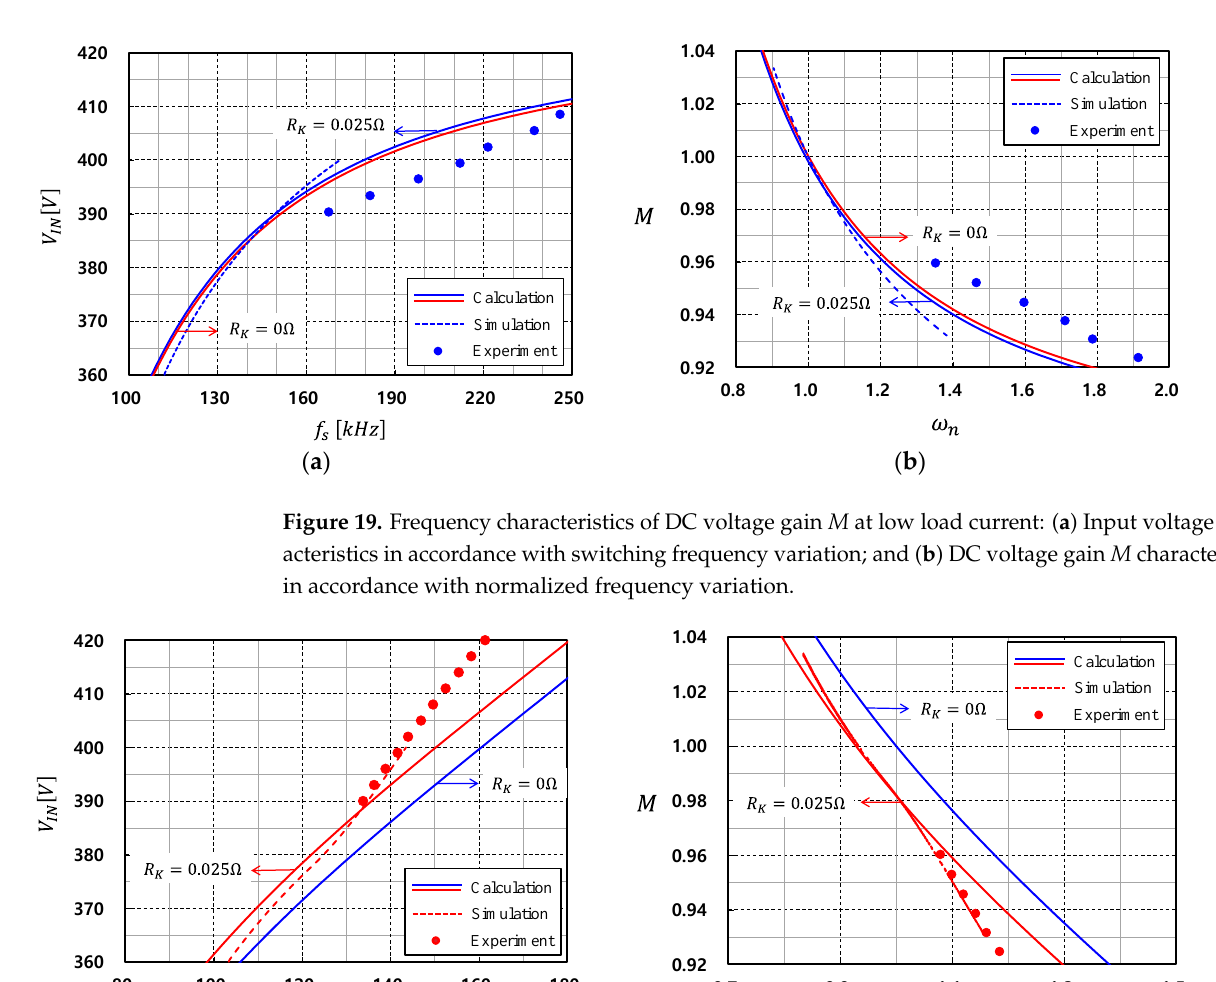
Figure 22. Measured power conversion efficiency of the experimental circuit. 5. Discussion In order to confirm the validity of the steady-state characteristic equation and the optimal design process, a converter with a maximum output of 2 kW, an input voltage of 390 V, an output voltage of 54 V, and a resonance frequency of 125 kHz was designed, and we compared the simulation, calculation, and experimental results. First, at low out- put current, there was a difference between the experimental value and the calculated value due to the fundamental harmonic approximation (FHA) method, which increases the error at no load, being used for the voltage gain equation. As the load power increased, the calculation, simulation, and experimental results showed similar trends. In particular,